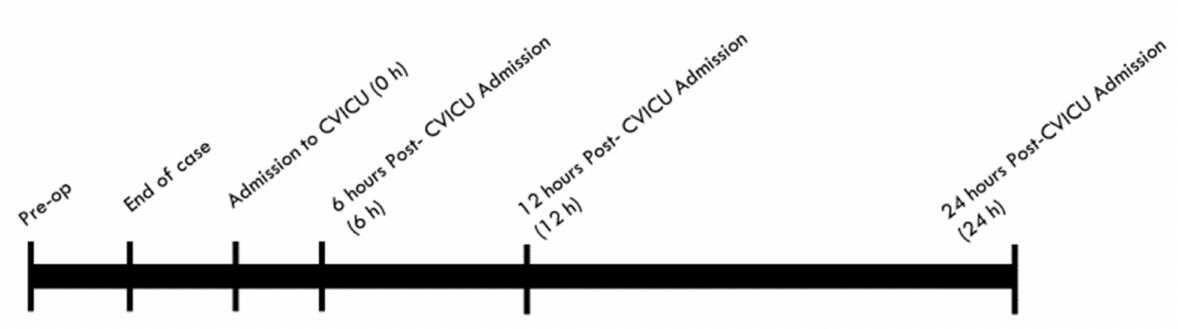
Figure 1. Sample collection timeline. CVICU = cardiovascular intensive care